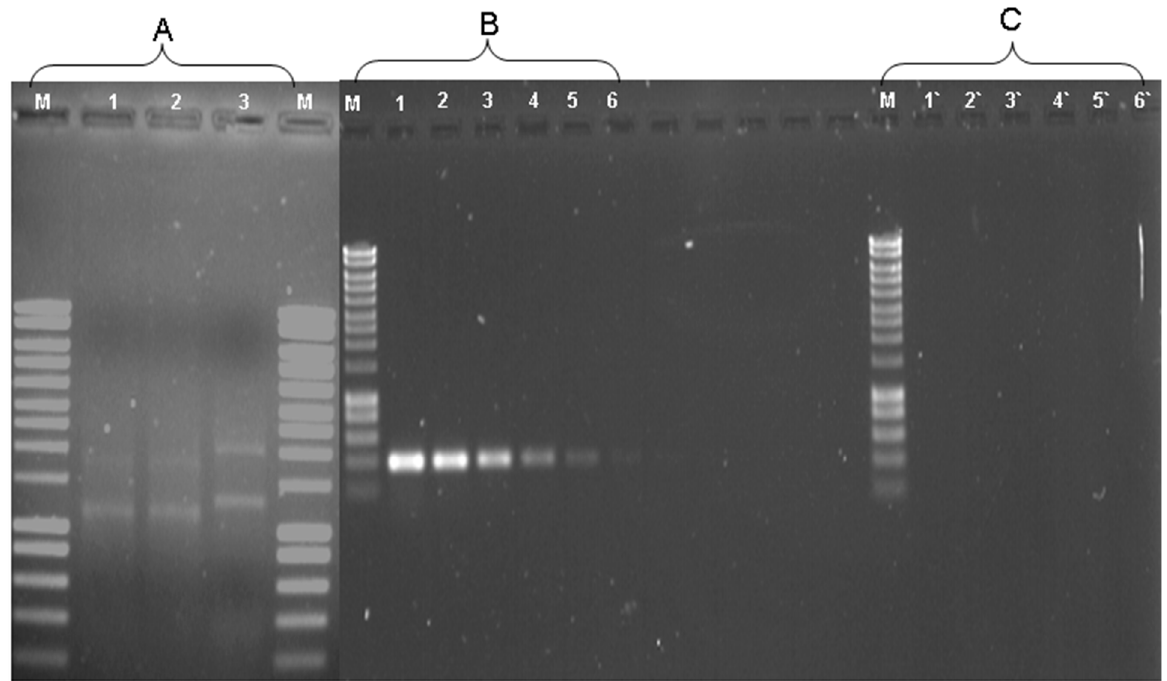
Figure 3. RNA extraction ( A ) from Chlorobenzene (lanes 1 and 2) and Fructose (lane 3). RT ‐ PCR amplification of CBA ‐ mRNA from Alcanivorax sp. strain HA03 grown on Chlorobenzene and on fructose was serially diluted (3.2 ‐ fold) with nuclease ‐ free water, and 1 μ L of each dilution was sub ‐ jected to amplification by PCR. cDNA from Chlorobenzene ( B ) (Lanes 1–6) and from fructose ( C ) (lanes 1`–6`). M, molecular weight marker Hyperladder 1 (Bioline).